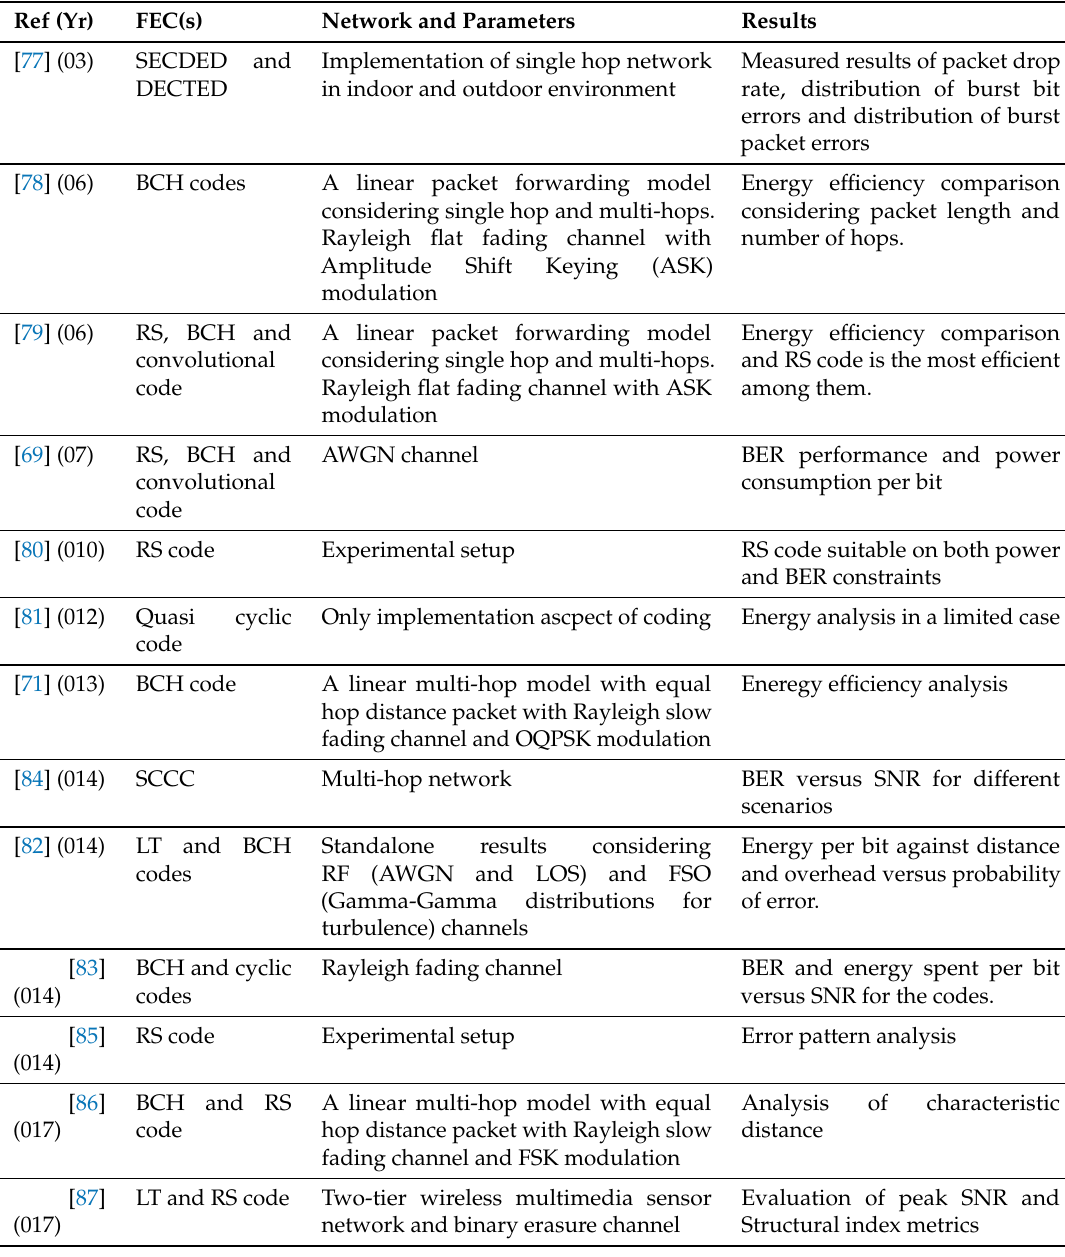
Table 3. A review of FEC based ECS for